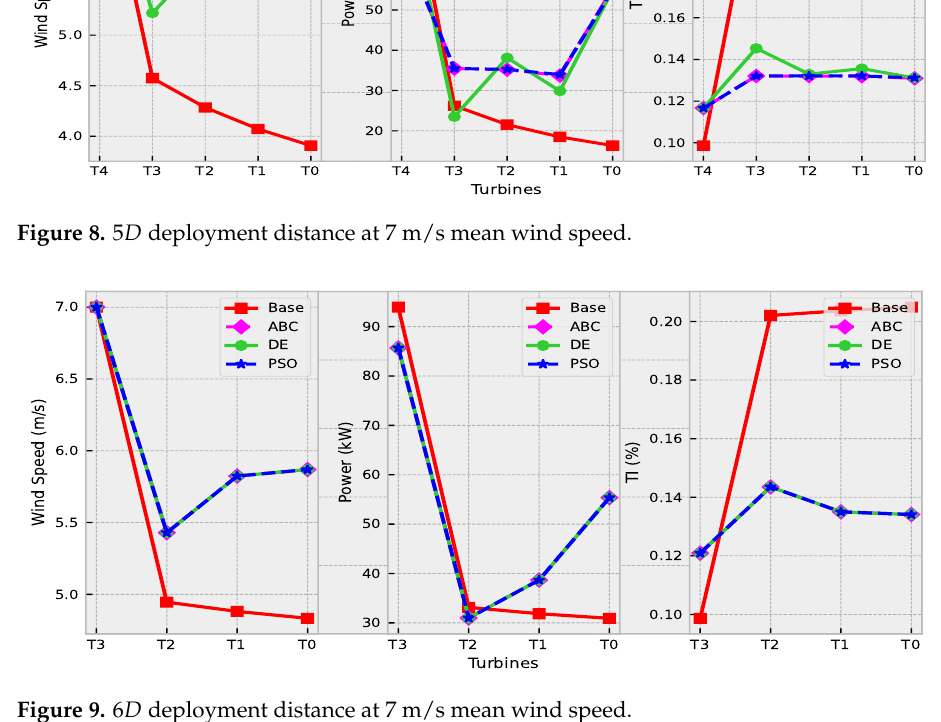
Figure 9. 6 D deployment distance at 7 m/s mean wind speed.